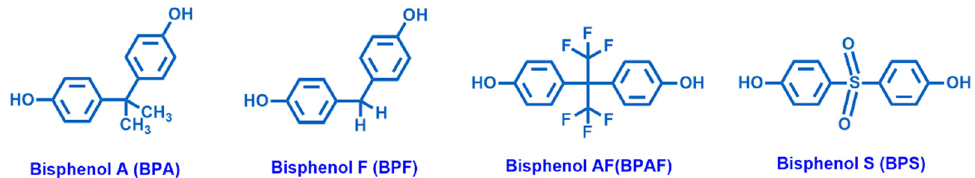
Figure 2. Chemical structures of Bisphenol A (BPA), Bisphenol F (BPF), Bisphenol AF (BPAF) and Bisphenol S (BPS).